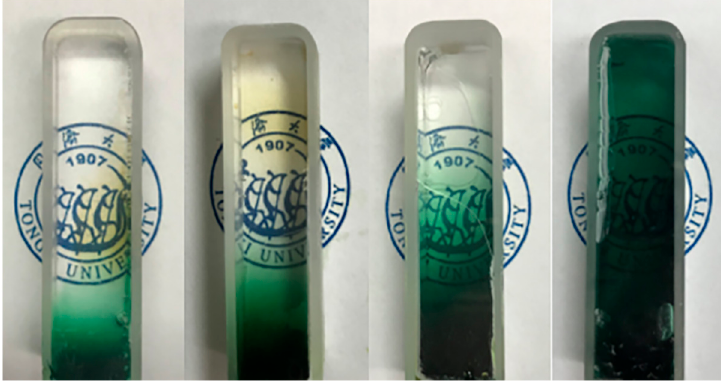
Figure 7. The diffusion process of Fe 2+ into the gel before supercritical drying with the mold of cuvette.